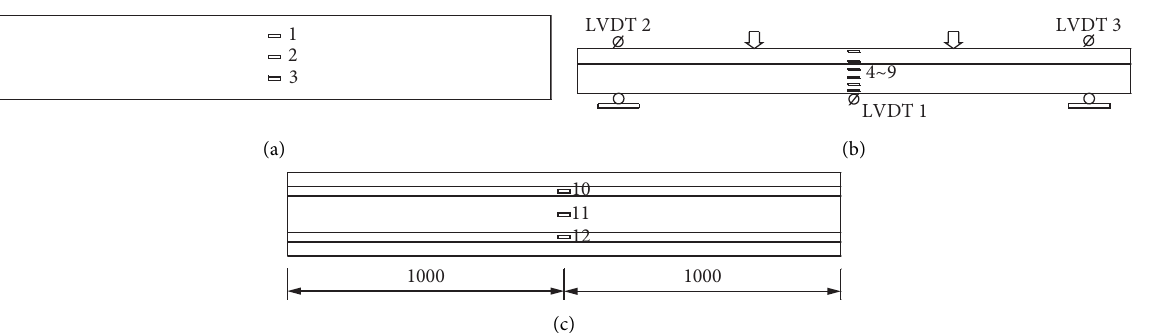
Figure 4: Locations of LVDTs and strain gauges: (a) plane view from the top, (b) side view, and (c) plane view from the bottom (units: